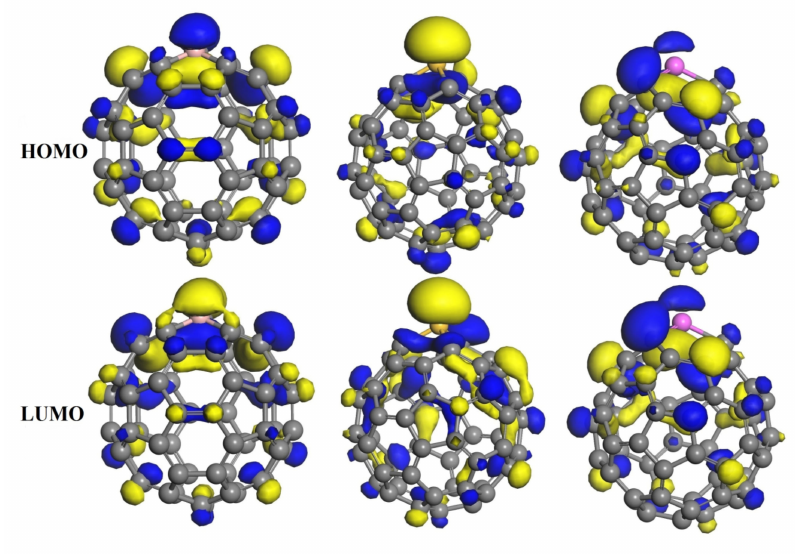
Figure 5. The HOMO and LUMO pictures of the BC 59 , SiC 59 , and AlC 59 molecules.